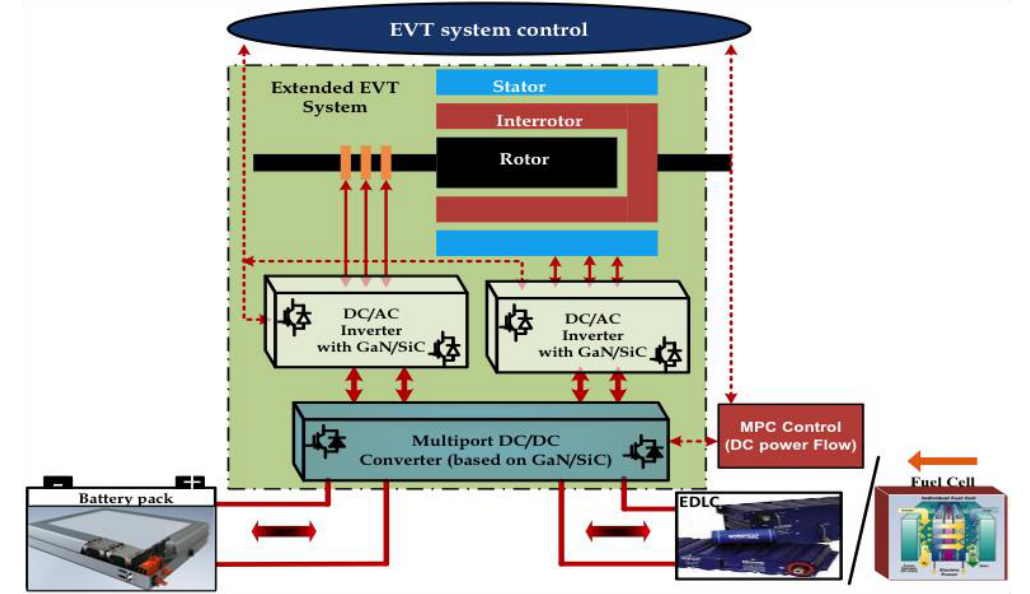
Figure 1. Multiport Converter integrated into the EVT-based powertrain.